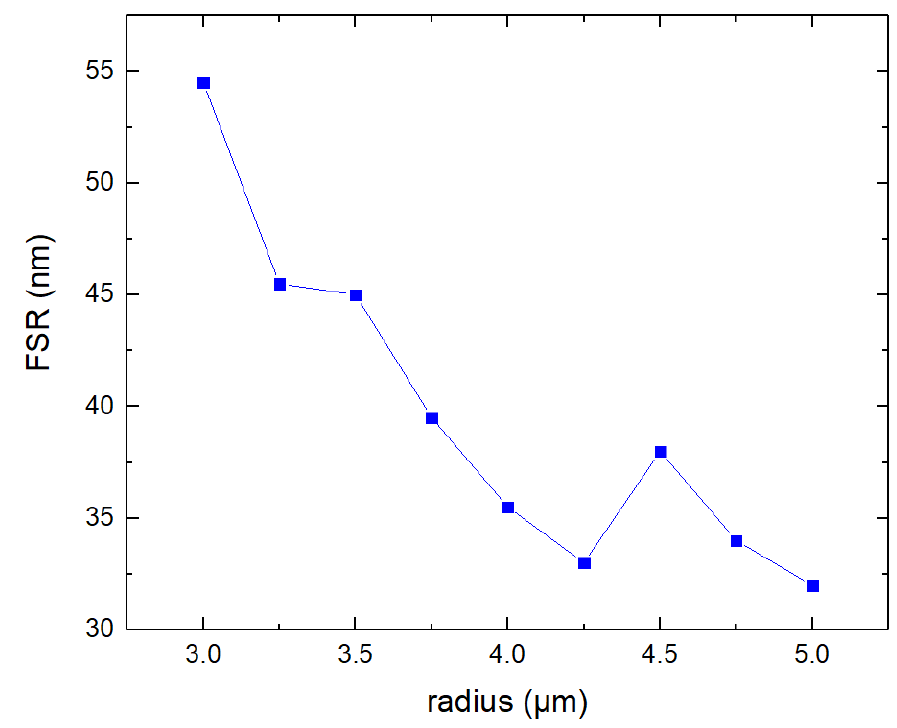
Figure 6. FSR under different radius.